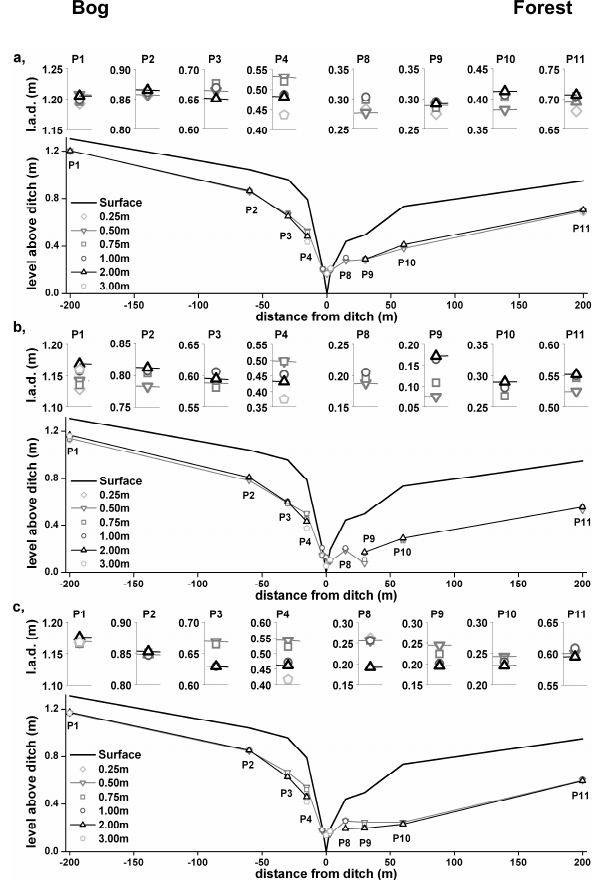
Fig. 4. Hydraulic heads of all piezometer nests on three different days: 13 August (a) , 2 September (b) and 4 October (c) . Hydraulic potential at 0.5m depth is marked with grey reversed triangles and at 2.0m depth with black triangles. Little diagrams above the panels are close-ups of the hydraulic potentials of each piezometer nest as shown in the panels and are given in units of level above the ditch (l.a.d.) in meters. The close-ups illustrate the occurrence of both recharging hydraulic gradients (e.g. a piezometer nest P4) and discharging conditions (e.g. b piezometer nest P9). Peat depth is vertically